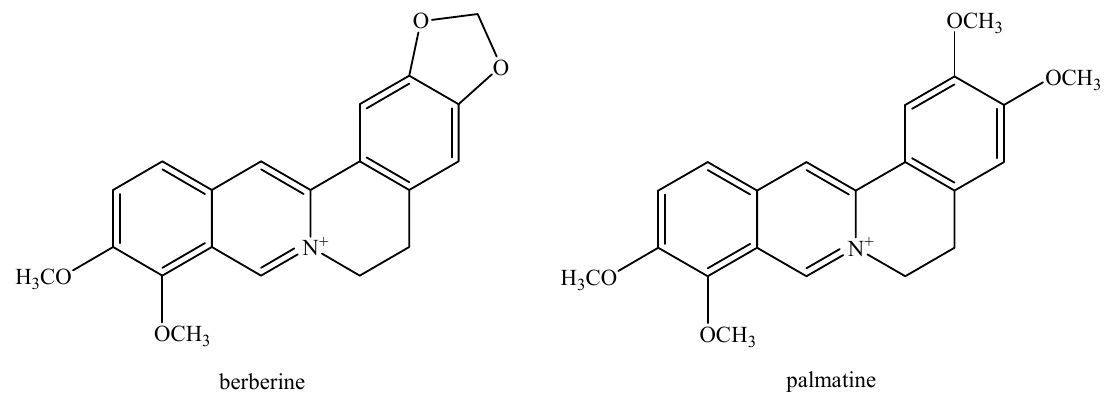
Figure 1. Structures of berberine and palmatine.